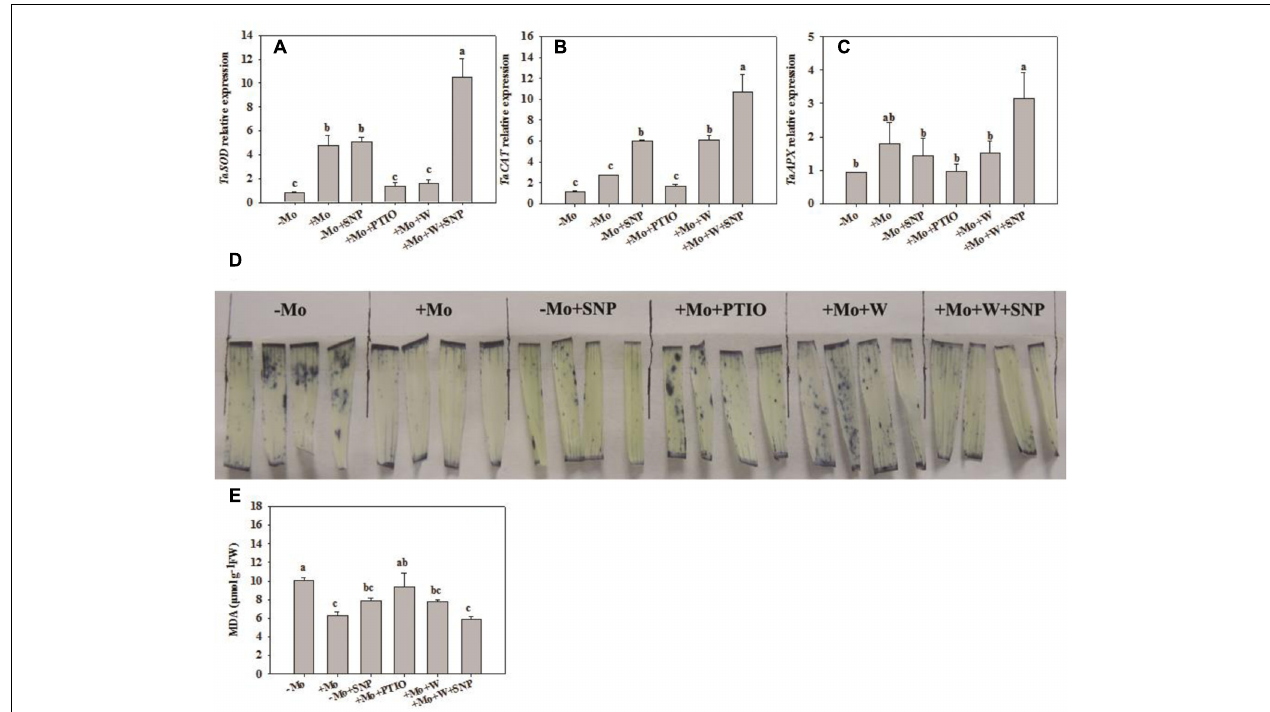
FIGURE 6 | Effects of molybdenum (Mo), 100 µ M tungsten (W, Mo-enzymes inhibitors), 200 µ M 2-phenyl-4,4,5,5-tetramethylimidazoline-3-oxide-1-oxyl (PTIO, NO scavenger), and 100 µ M sodium nitroprusside (SNP, NO donor) on transcripts of antioxidant enzymes, superoxide anion (O 2 − ) accumulations and malonaldehyde (MDA) contents in wheat leaves. The 30-day-old seedlings grown in –Mo and +Mo Hoagland solutions were detached and placed in distilled water for 2 h to eliminate potential wound stress and firstly pretreated with/without 200 µ M PTIO or 100 µ M W for 4 h, and then exposed to 10% polyethylene glycol 6000 (PEG) with/without 100 µ M SNP for 6 h. Seedlings cultivated with –Mo and +Mo solutions were regarded as the control. Different letters indicate significant differences between treatments by the Duncan-test ( p < 0.05, n =